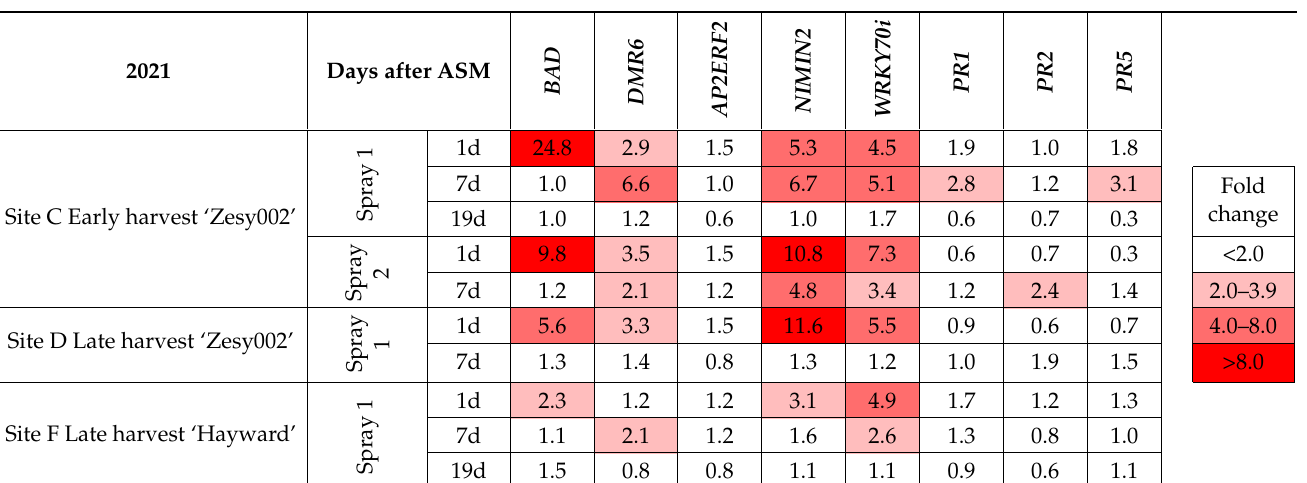
Table 2. Heat map showing the expression of selected defence-related genes in Actinidia chinensis var. chinensis “Zesy002” vines and A. chinensis var. deliciosa “Hayward” after harvest in 2021. Vines were sprayed with Kocide ® Opti™ (Cu) or with a tank mix containing Kocide Opti and Actigard ® (acibenzolar-S-methyl (ASM) + Cu). Treatments were applied at site C on 29 April and 20 May, at site D on 17 May and 9 June, and at site F on 3 June. Data were log2 transformed for analysis. The numerical values indicate the fold-change relative to the copper control. Fold-changes of 2 or higher (or 0.5 or lower) were all statistically significant ( p <